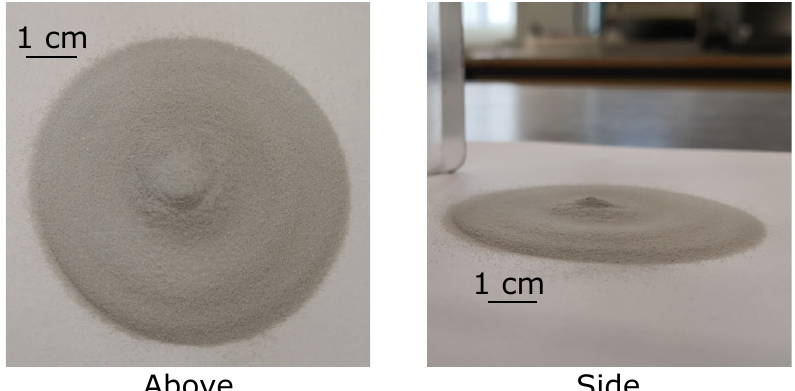
Figure 13. Results of cold experiments for bulk alumina, type